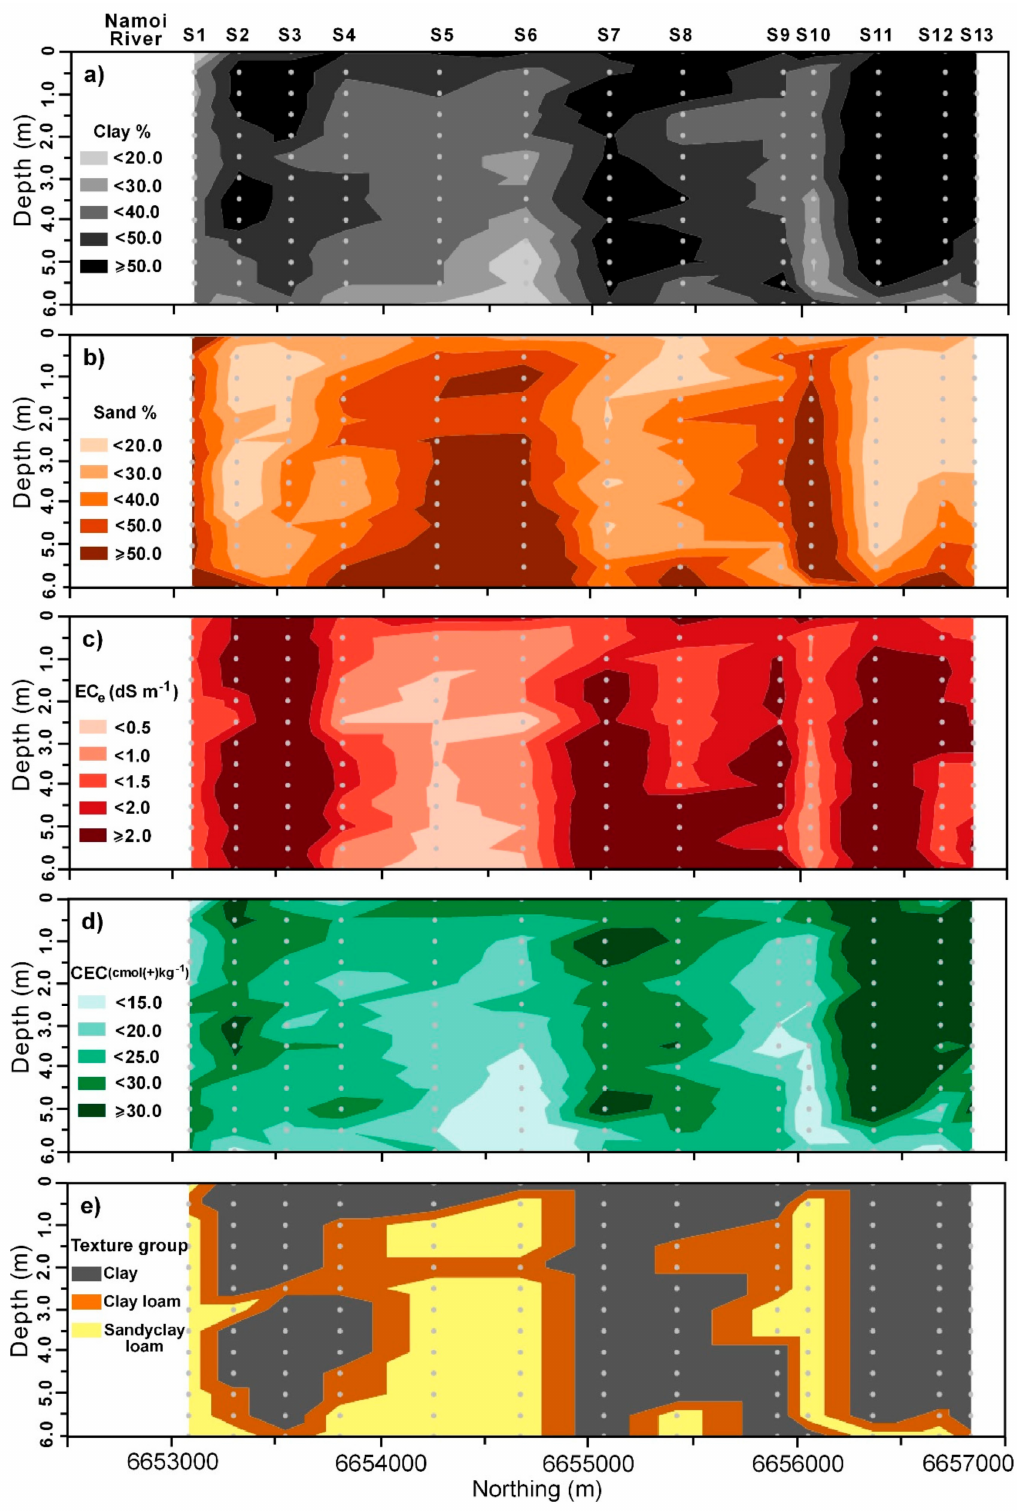
Figure 3. Contour plots of the spatial distribution of soil physical and chemical properties at soil sampling sites (13) along the channel, including ( a ) clay (%), ( b ) sand (%), ( c ) electrical conductivity of a saturated soil paste extract (EC e —dS m − 1 ) estimated from 1-part soil, 5-part water solution, ( d ) cation exchange capacity (CEC—cmol( + ) kg − 1 ) and ( e ) the contour plots of soil textures at the soil sampling sites ( ×